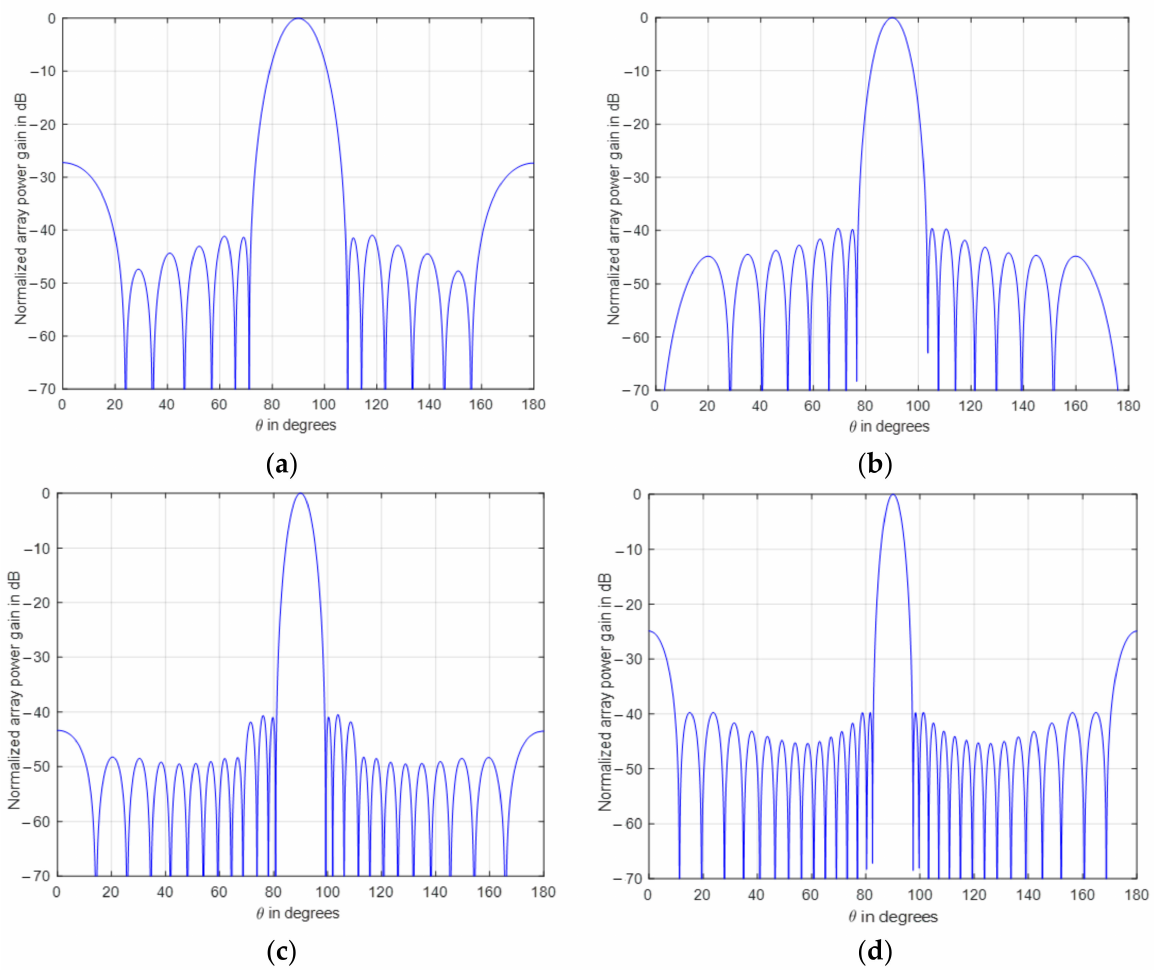
Figure 5. SSL reduction using SSR algorithm for 16-element linear array at: ( a ) δ = 0.7, d n = 0.35 λ , and C = 8, ( b ) δ = 0.7, d n = 0.5 λ , and C = 8, ( c ) δ = 0.3, d n = 0.75 λ , and C = 25, ( d ) δ = 0.3, d n = 0.9 λ , and C =